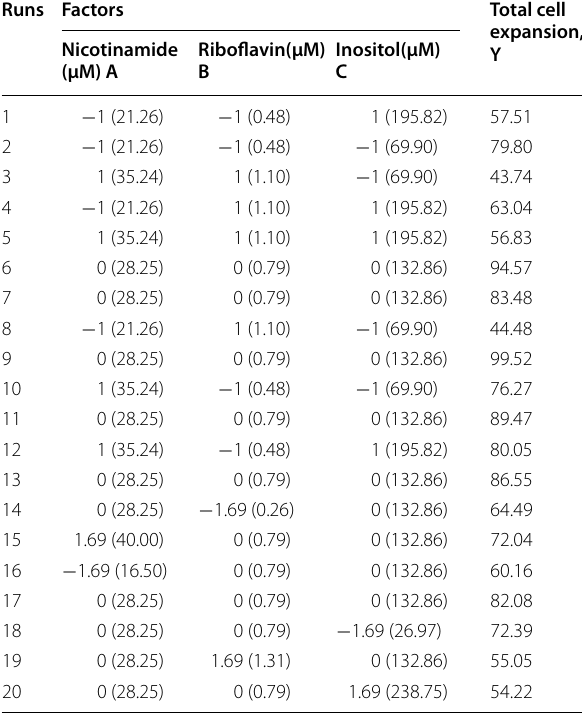
Table 1 Central composite design and experimental data used for the response surface analysis Runs